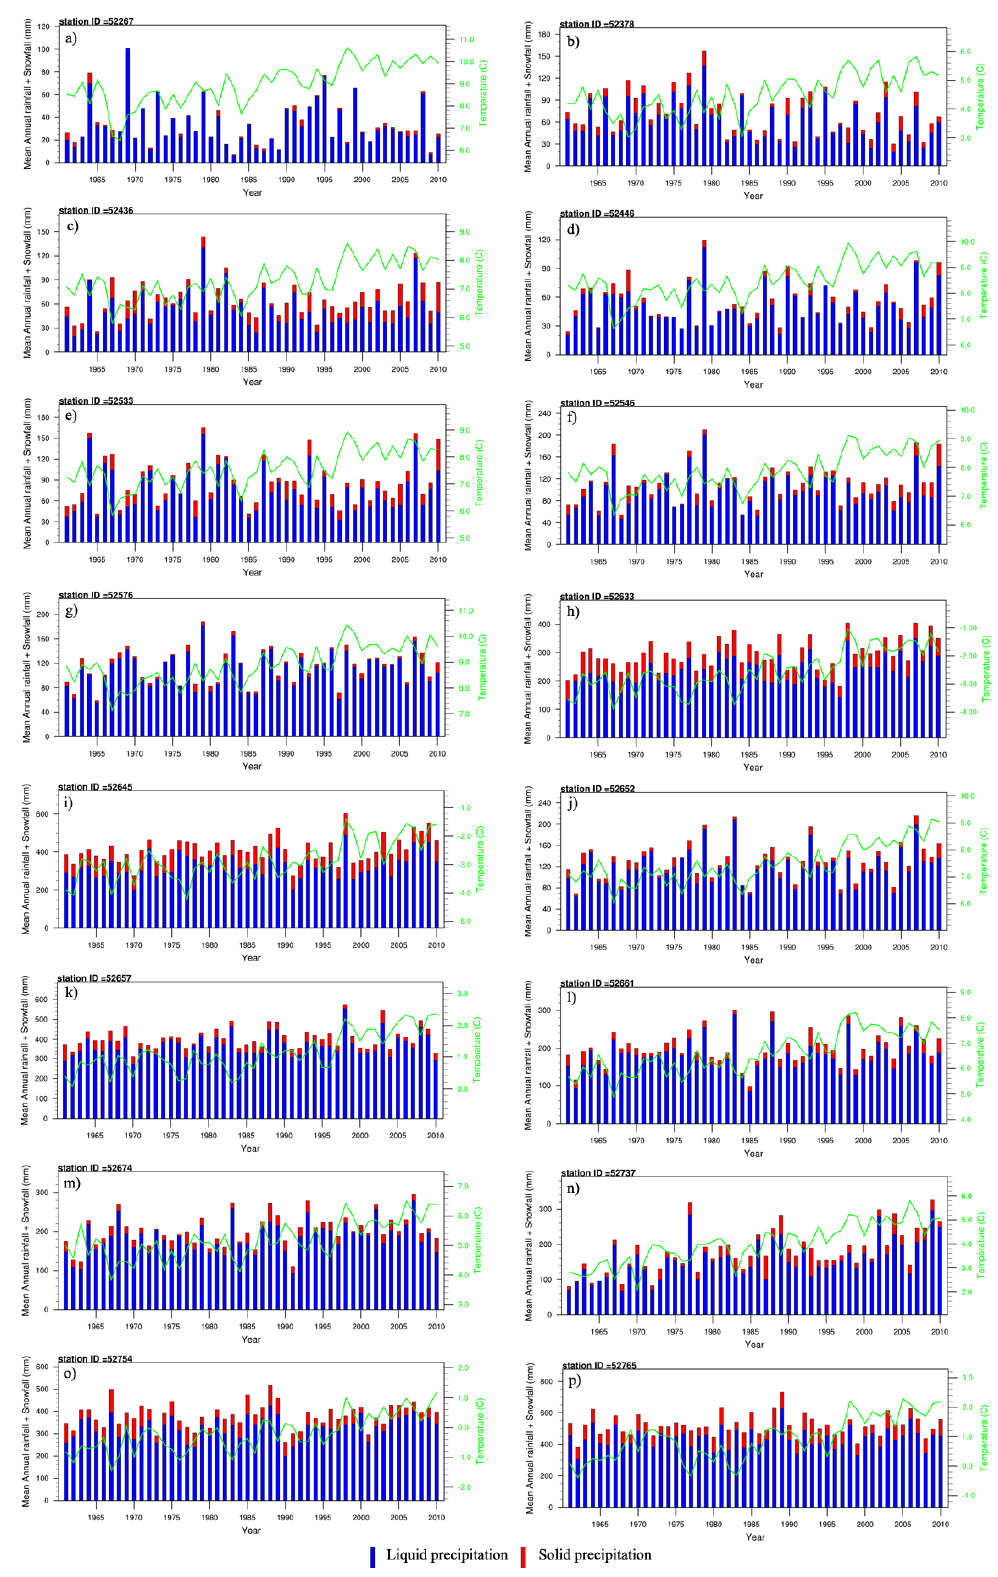
Figure 8. Annual precipitation, snowfall and 2m temperature from CMA station observation data from 1960 to 2010. Station IDs from ( a ) to ( p ) are 52267, 52378, 52436, 52446, 52533, 52546, 52576, 52633, 52645, 52652, 52657, 52661, 52674, 52737, 52754, and 52765, respectively.